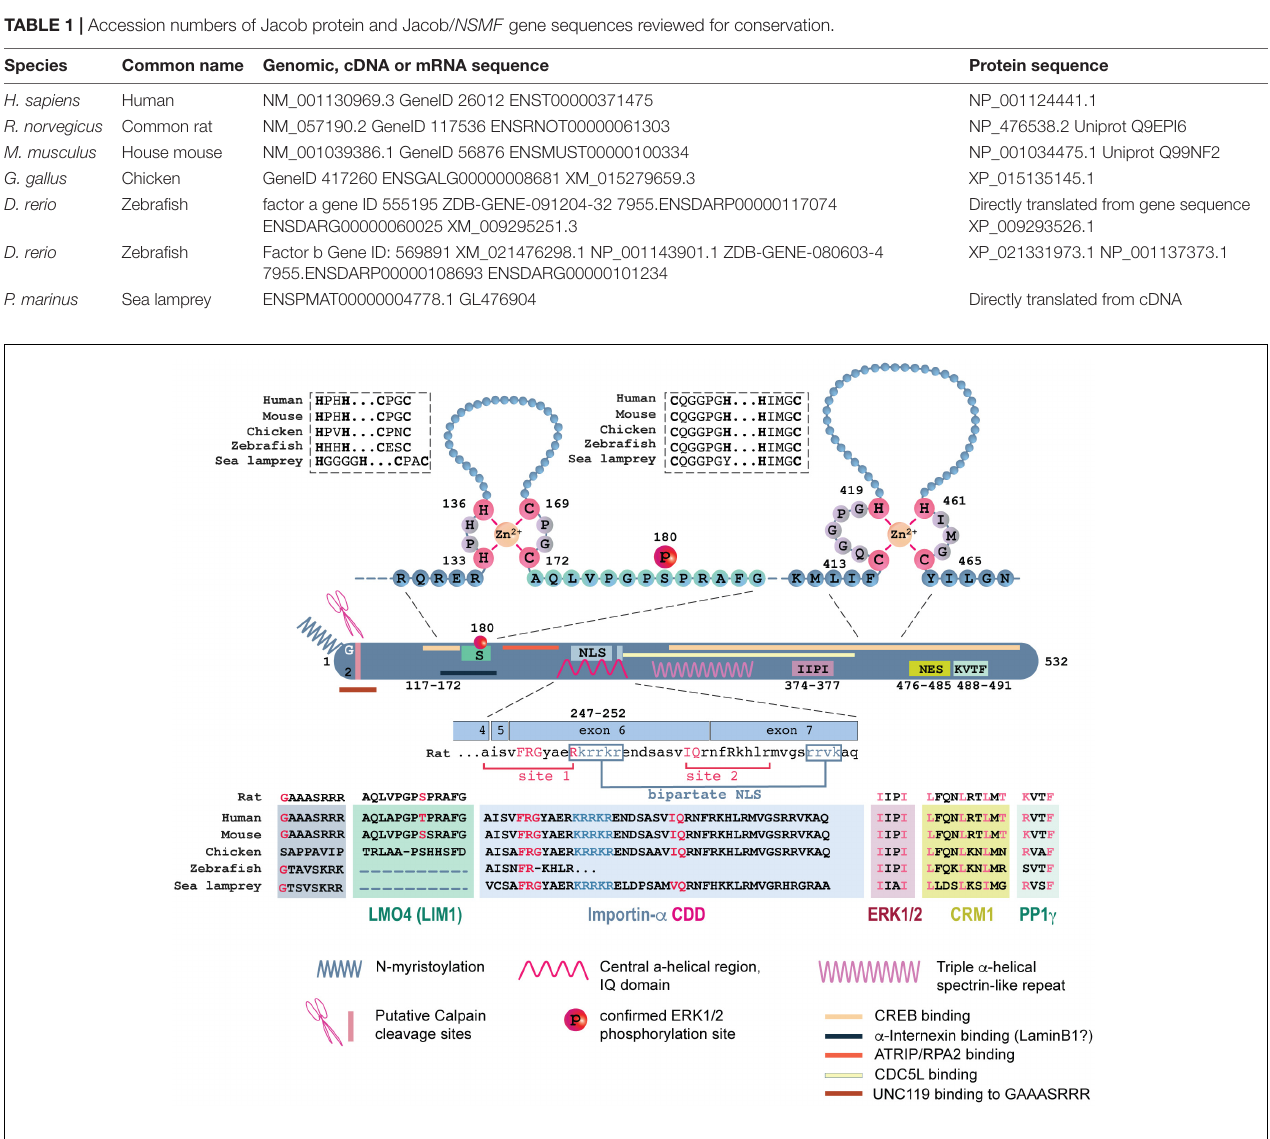
FIGURE 3 | Jacob interactome and motif conservation. Schematic representation of the binding motifs and binding regions for multiple confirmed interactors (represented by shaded boxes). The upper panel represents two well-conserved putative zinc finger domains (HH-CC and CH-HC consensus, modified from Xu et al., 2010). Cysteine or histidine residues directly binding to zinc ions are indicated in pink. Sequence conservation for the zinc finger domains is indicated in bold inside the boxes. Zebrafish Jacob (factor a) sequence is used for the panel. Amino acids encompassing the LMO4 (LIM1) binding site located directly after the first zinc finger domain are indicated in green. Color bars indicate interacting partners. Color boxes indicate motifs. Crucial amino acids residues within the motives are indicated in red. RPA2, replication protein A 2; ATR, ataxia telangiectasia and Rad3-related protein; CDC5L, Cell Division Cycle 5 Like; ATRIP, ATR interacting protein; CDD, Caldendrin; UNC119, solubilizing